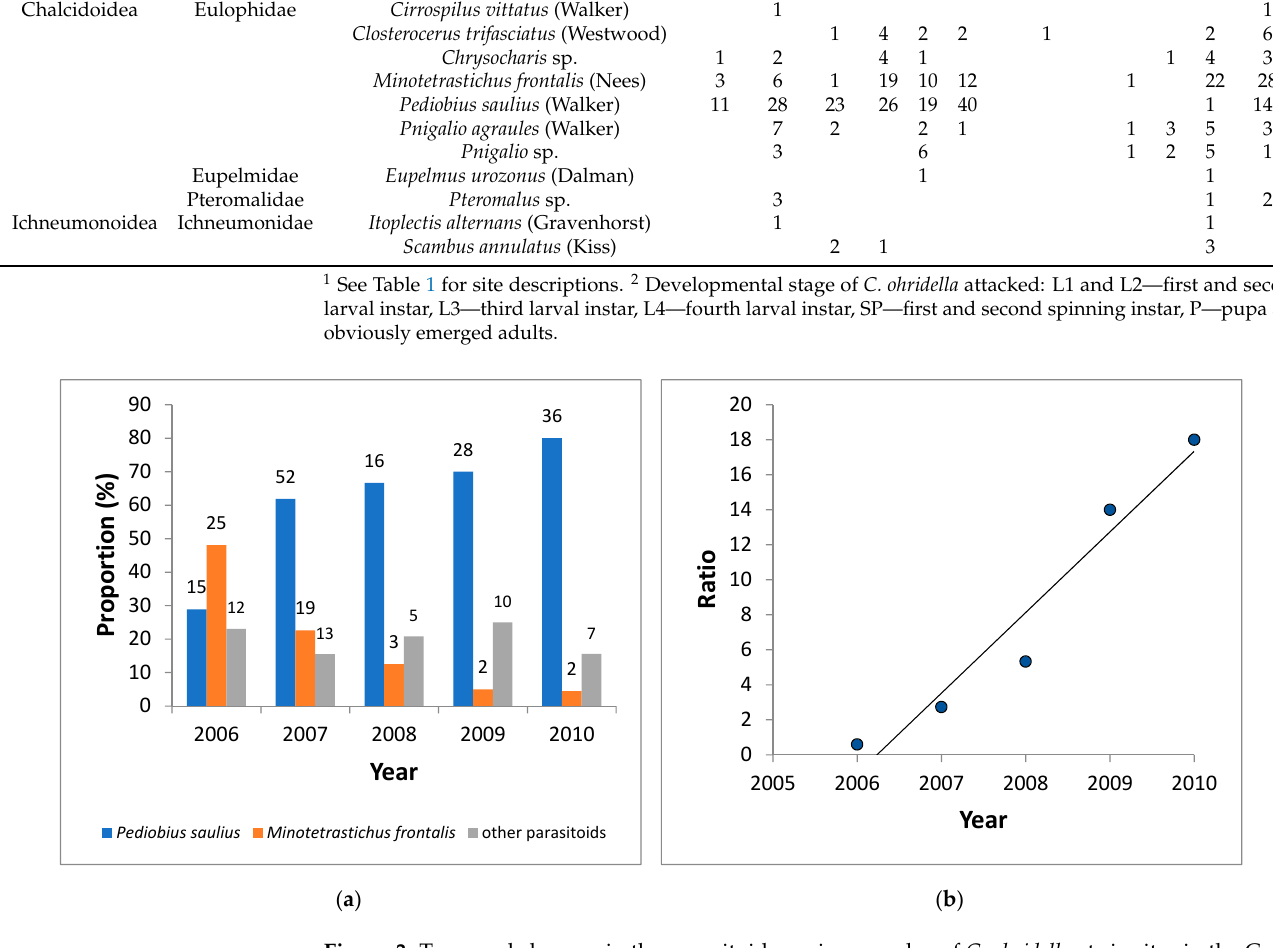
Figure 3. Temporal changes in the parasitoid species complex of C. ohridella at six sites in the Czech Republic: ( a ) proportion among all parasitoids; numbers above columns represent the number of parasitized host individuals; ( b ) changes in P. saulis/M. frontalis ratio fitted by linear trend.